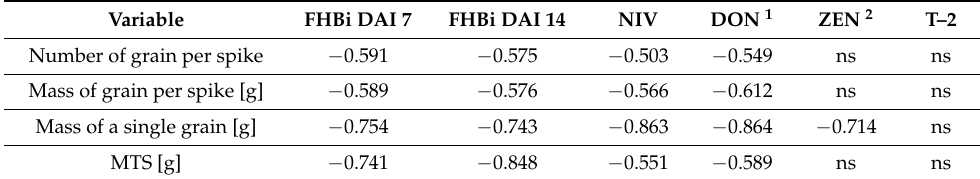
Table 5. Pearson’s coefficients of linear correlation ( p < 0.05) between Fusarium head blight index (FHBi) evaluated 7 and 14 days after inoculation (DAI 7 and DAI 14), mycotoxin content in grain and yield parameters.